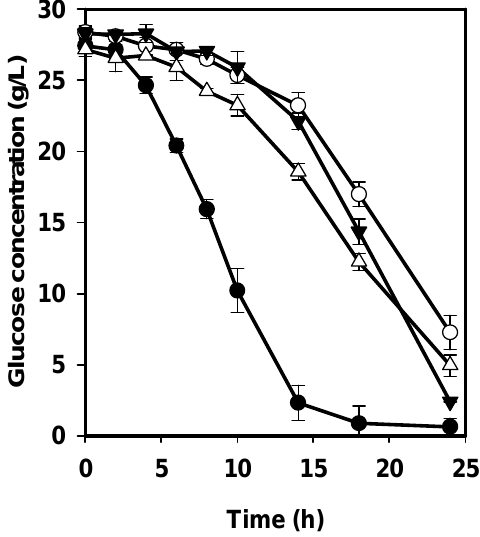
Figure 3 . Glucose assimilation on anaerobic batch cultivation of: ( (cid:1) ) S. cerevisiae CBS 8066 on glucose and defined synthetic medium (DSM); (  ) Flocculating yeast on glucose in defined synthetic medium (DSM); ( (cid:1) ) Flocculating yeast on hydrolyzates in DSM; and ( (cid:2) ) Flocculating yeast on glucose in YPD medium.